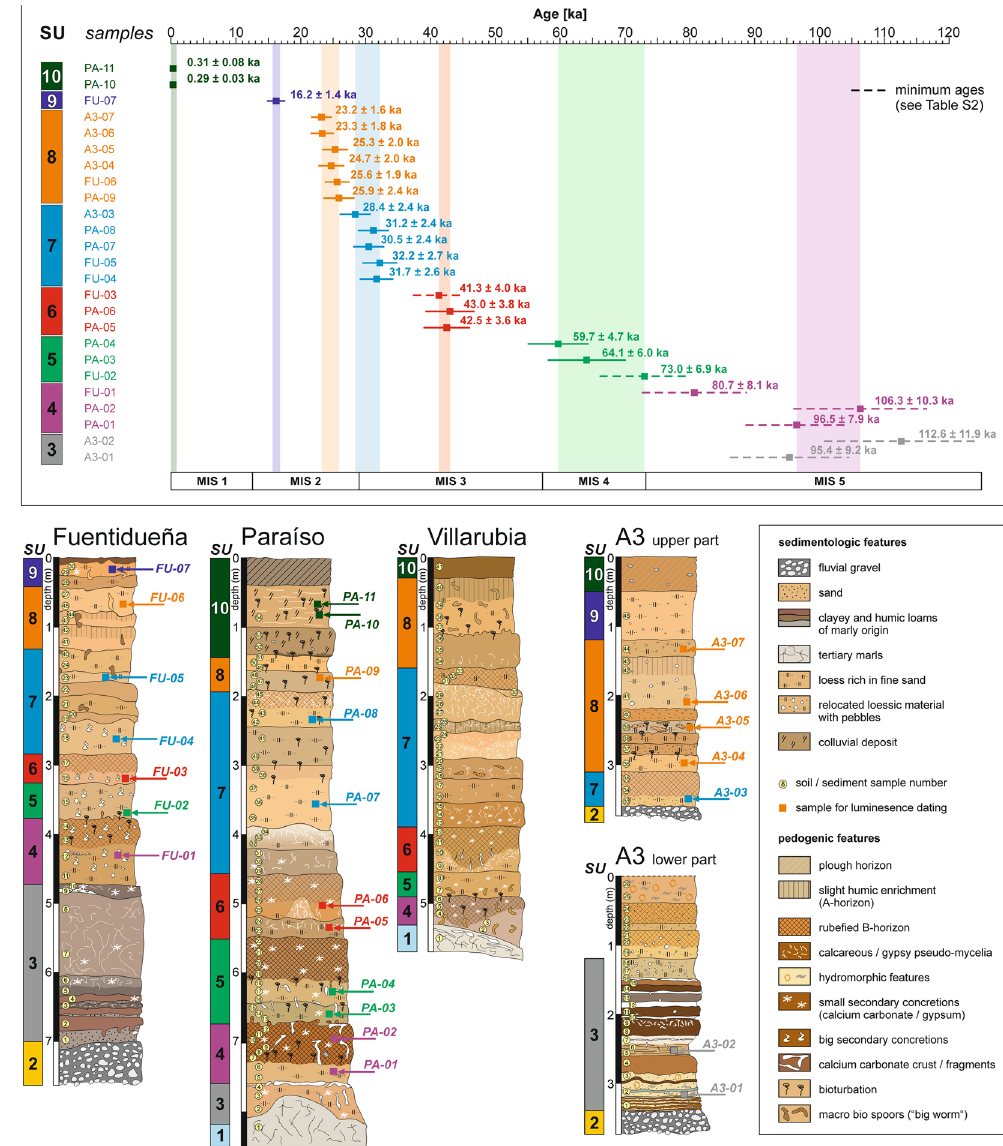
Figure 2. Stratigraphic evidences and age model of the Tagus loess record. Treaded profile sections are shown, together with sampling positions and ages obtained. The classification into sediment units is based on the results presented in Fig. S6. The detailed expose of the OSL ages is to be found in SI Text